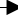
Fig. 4. The time variations of the vibrational and neutral temperatures and populations of the first five vibrational levels of N 2 in comparison with the Boltzmann distribution during the 16–23 March period at the F2 peak altitude. The solid lines show the modeled T y ; n 1 = n 1 B ; n 3 = n 3 B , and n 5 = n 5 B and the dashed lines show the modeled T n ; n 2 = n 2 B , and n 4 = n 4 B . The O (cid:135) (cid:255) O frequencies given by Salah (1993) and the approach of Eqs. A.18, A.20 based on the method of Richards (1991) for obtaining equivalent neutral winds from the height of the F2 peak electron density was used in the model of the ionosphere and plasmasphere. The O (cid:135) (cid:255) O collision frequencies given by Salah (1993) and the MSIS-86 model with the adjusted N 2 and O 2 densities were used in the IZMIRAN model